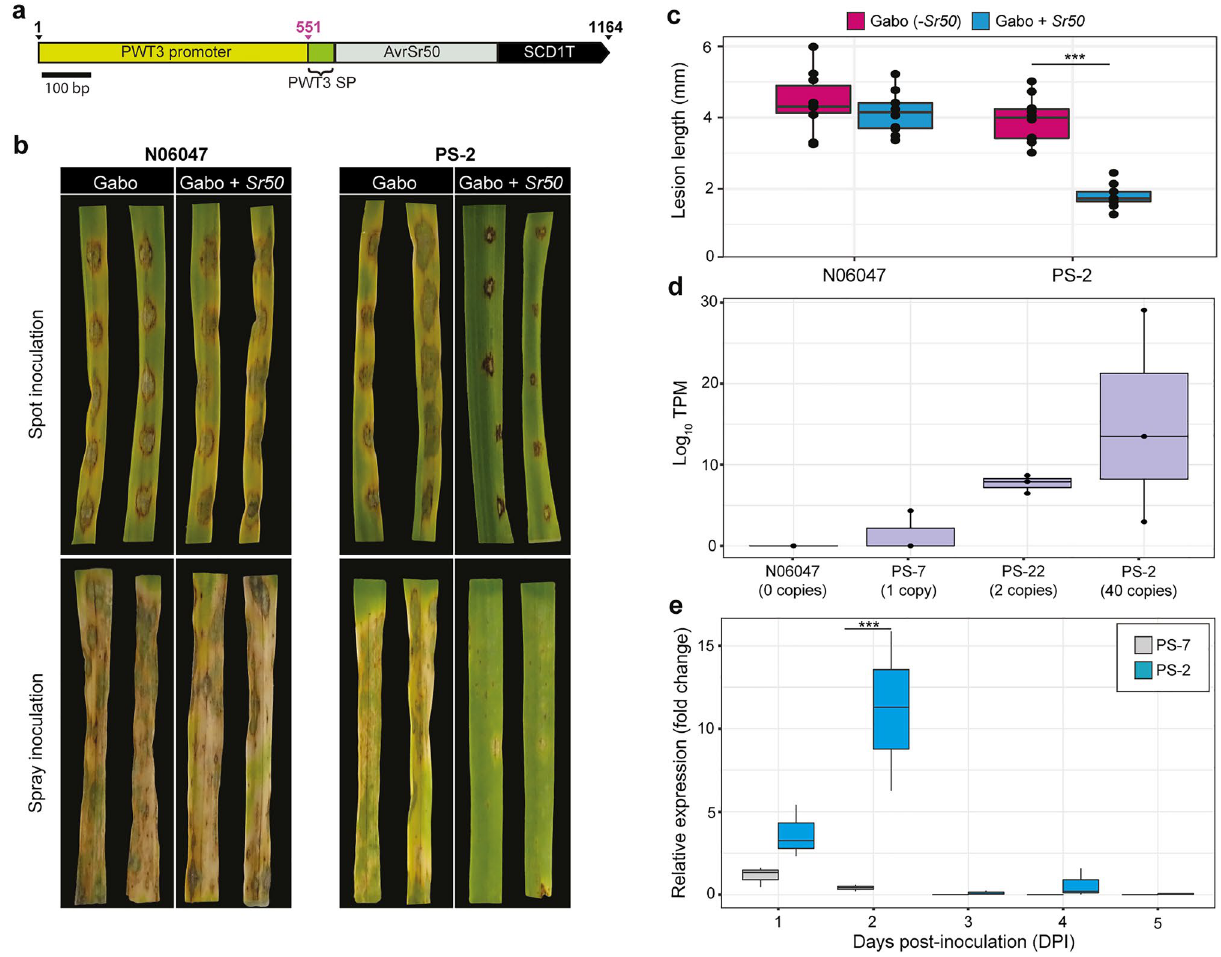
Figure 2. Introduction of Pgt AvrSr50 into MoT under the PWT3 promoter and signal peptide induced a visible Sr50 -mediated HR phenotype when the transgene was highly expressed. ( a ) Schematic representation of the pCB-PWT3p - PWT3SP-AvrSr50 - stop vector used for transformation of MoT (strain N06047). Scale bar represents 100 bp; SP, signal peptide. ( b,c ) Introduction of PWT3p::PWT3SP::AvrSr50 into MoT induced a visible Sr50 -mediated hypersensitive response (HR) for one transformant (termed PS-2), specifically restricting its growth when inoculated onto the wheat line Gabo + Sr50 . Conidial suspensions from the MoT strain N06047 and the PS-2 transformant were inoculated onto the second leaf of two-week old wheat plants (lines Gabo [ Sr50- ] and Gabo + Sr50 ). Inoculations were performed using both the spot and spray inoculation methods and three biological replicates (separate leaves) assessed. Images were taken and lesion lengths analysed at 4 days post-inoculation (dpi). ( d ) AvrSr50 expression correlated with the number of AvrSr50 insertion events in MoT. AvrSr50 expression level was determined from RNA-seq analysis of wheat leaves (Gabo –Sr50 ) harvested 3 dpi with three independent transformants PS-7, PS-22, PS-2, and the wild type MoT N06047 strain. Three biological replicates (separate plants) were analysed. Expression data is represented as Log 10 TPM (transcripts per million). Each data point represents a single biological replicate (separate plants and experiments). ( e ) AvrSr50 expression peaked at 2 dpi for the PS-2 transformant. Relative expression was assessed by RT-qPCR of wheat leaves (Gabo -Sr50 ) following infection with PS-7 (single copy) and PS-2 (40 copies) transformants. Three biological replicates (separate leaves) were analysed for each time-point. Relative expression is shown as the fold change relative to PS-7 infected leaves at 1 dpi. Asterisks denote statistically significant differences (***: p < 0.001; 2-tailed t gene (MGG_01760—subunit of the exocyst complex) did not show increased expression in any of the trans- formants (Supplementary Figure. S6). We also assessed the expression levels of several genes encoding Avr and Avr homologues in the PS-2 transformant and wild-type MoT N06047 strain. This analysis illustrated that the expression of AvrSr50 was similar in the PS-2 transformant to the expression of AvrRmg8 , AvrPizt , Avr1CO39 and AvrPib (Supplementary Figure. S7), indicating that the levels of AvrSr50 expression in PS-2 were similar to those for endogenous MoT Avr genes. To further explore the potential increase in expression of AvrSr50 in the PS-2 transformant, we repeated the infection assays on the wheat line Gabo with the single copy (PS-7) and 40 copy (PS-2) transformants and performed RT-qPCR experiments at 1, 2, 3, 4 and 5 dpi. We found that the 40 copy transformant (PS-2) had consistently higher levels of AvrSr50 expression across all time-points, with a statistically significant increase at